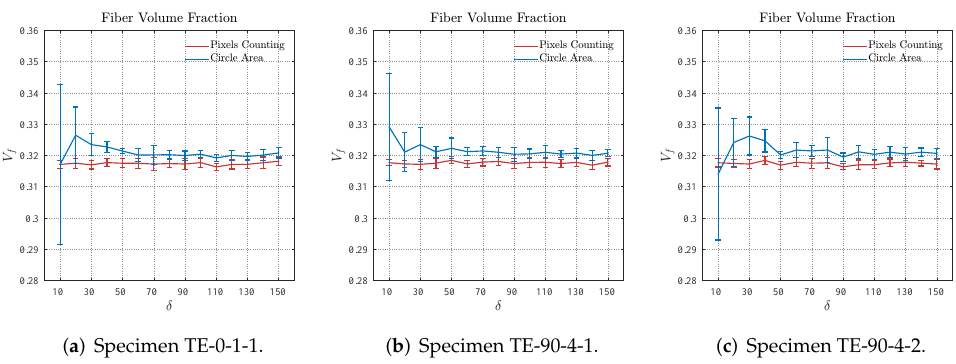
Figure 10. Fiber volume fraction computed for different sizes of cropped regions based on pixels counting and circumference